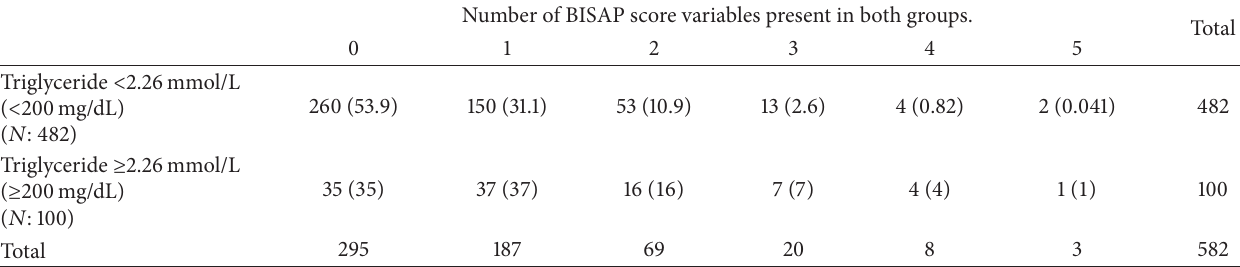
Table 5: Incidence of the Bedside Index for Severity in Acute Pancreatitis (BISAP) score in the two groups. Number of BISAP score variables present in both groups.